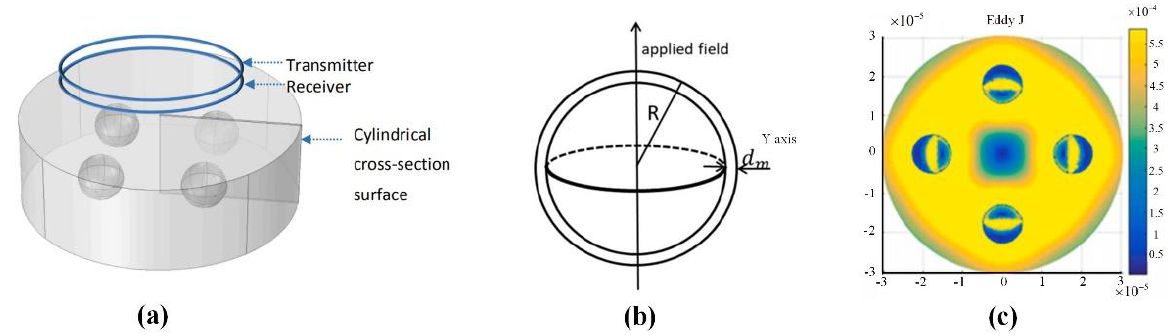
Figure 12. Three-dimension finite element model. ( a ) Measurement set-up. ( b ) Conductivity spectroscopy of fresh potato and defrosted potato. ( c ) Simulation model. Adapted with permission from ref. [102]. Copyright 2019